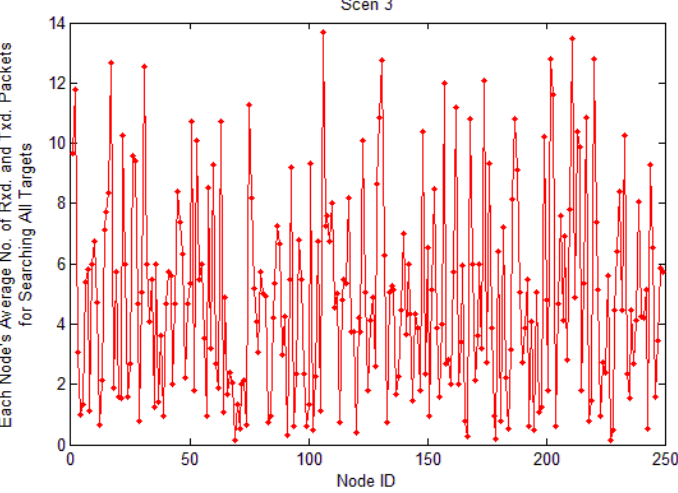
Figure 22. Average load of each node in Scenario 3.